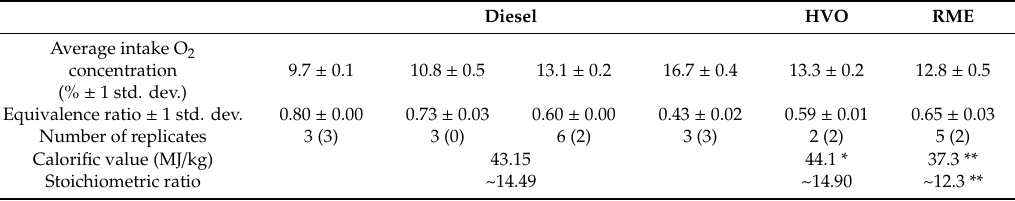
Table 1. A summary of the longer replicate experiments, including number of replicates, mean exhaust The number of replicates is the number of the filter collections of particulate matter (PM), the number of filters pooled and extracted for o ffl ine chemical analyses and reactive oxygen species (ROS) formation potential are denoted within brackets. No o ffl ine analyses were performed of diesel samples collected at 10.8% intake O 2 . Diesel HVO RME Average intake O 2 concentration (% ± 1 std. dev.) Equivalence ratio ± 1 std. dev. 0.80 ±